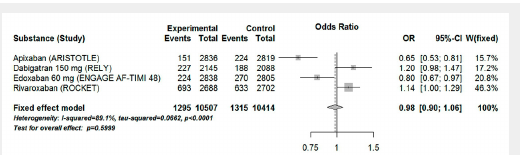
Forest plot of stroke or systemic embolism in patients with atrial fibrillation aged 75 years or over for analysis including low-dose dabigatran and edoxaban. CI = confidence interval; experimental = direct oral anticoagulants; control = vitamin K antagonists